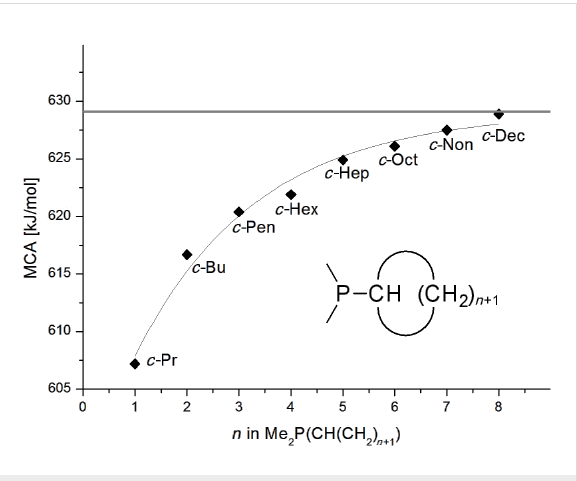
Figure 4: MCA values of monosubstituted phosphanes of general formula PMe 2 (CH(CH 2 ) n +1 ) ( n = 1–8, in kJ/mol).